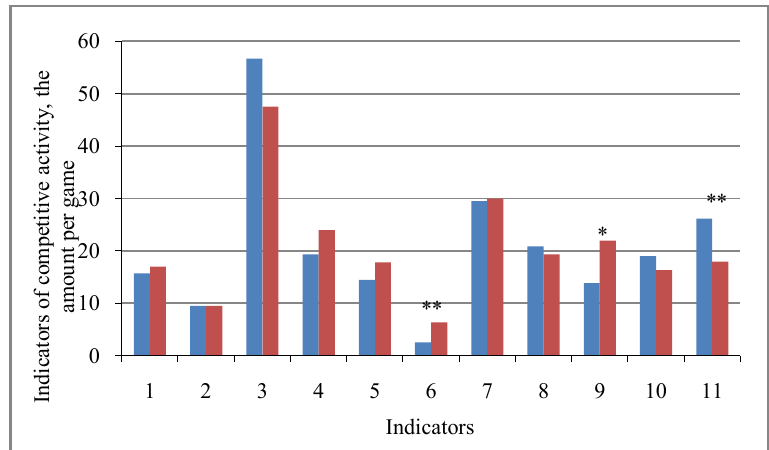
Fig.4. Indicators of competition functioning of Ukrainian women’s combined team (n = 12) and Lithuanian women’s combined team (n = 12) at basketball European championship for sportsmen with hearing problems: * - р<0.05; ** - р<0.01;